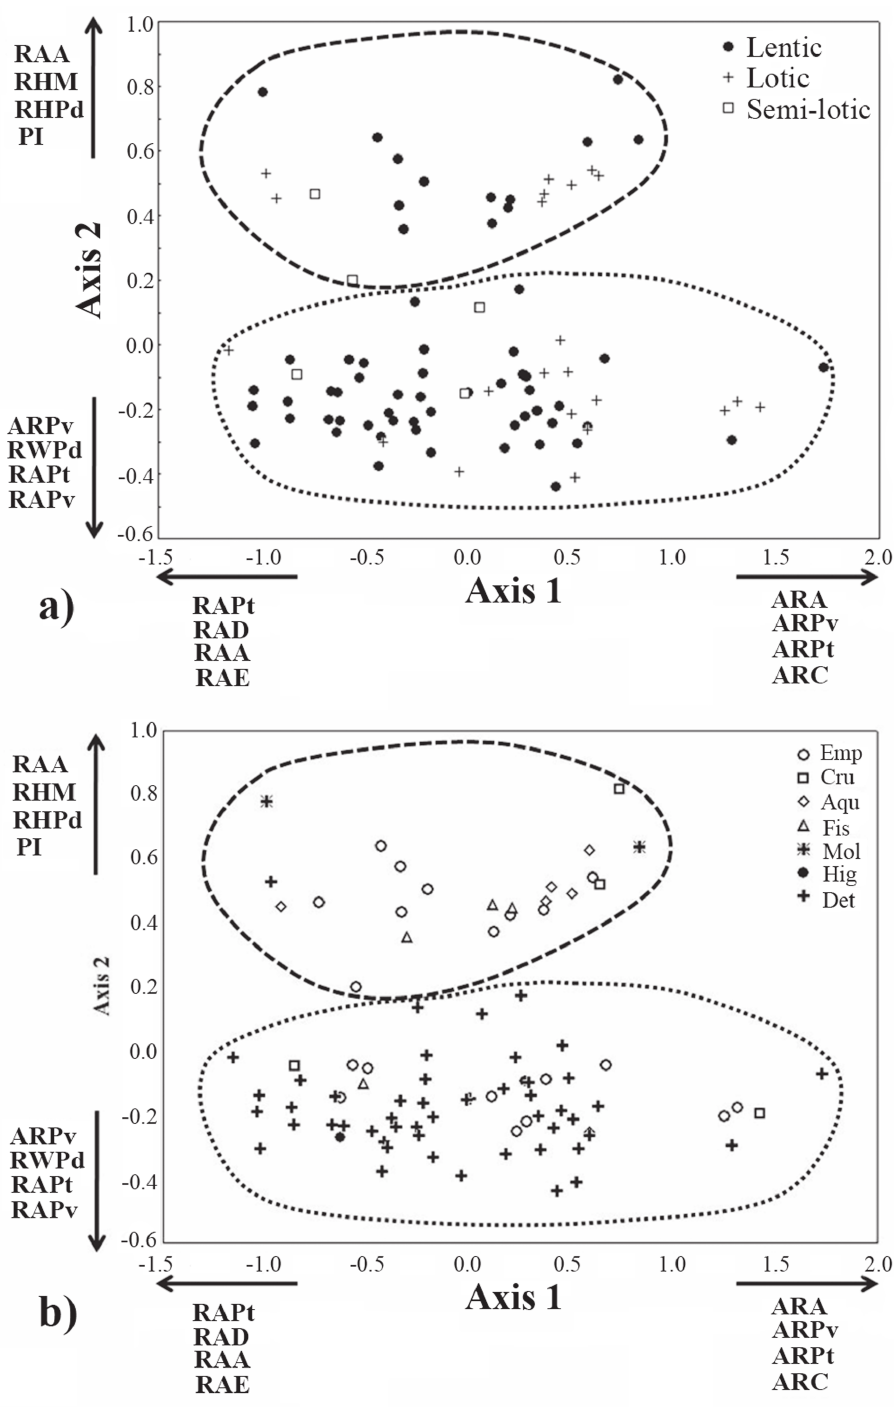
Fig. 1 . Dispersion of the scores of the first two PCA axes, calculated with the variance matrix of 22 ecomorphological indices. a) Scores classified by the type of environment; b) Scores classified by food resources, where: Emp = empty, Cru = crustacean, Aqu = aquatic insect, Fis = fish, Mol = mollusk, Hig = higher plant, Det = detritus. Dashed line: Crenicichla britskii ; dotted line: Satanoperca pappaterra . ARA = Aspect ratio of the anal fin; ARC = Aspect ratio of the caudal fin; ARPt = Aspect ratio of the pectoral fin; ARPv = Aspect ratio of the pelvic fin; PI = Protrusion index; RAA = Relative area of the anal fin; RAD = Relative area of the dorsal fin; RAE = Relative area of the eye; RAPt = Relative area of the pectoral fin ; RAPv = Relative area of the pelvic fin ; RHM = Relative height of the mouth; RHPd = Relative width of the caudal peduncle; RWPd = Relative width of the caudal